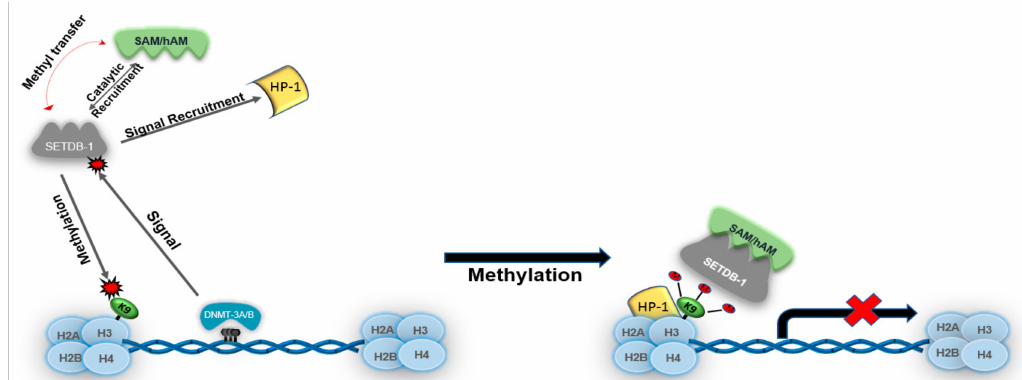
Figure 1. DNA-methyltransferase 3 A / B (DMNT-3 A / B) CpG island-mediated signaling of SET Domain Bifurcated Histone Lysine Methyltransferase 1 (SETDB1). SETDB1 methyltransferase activity